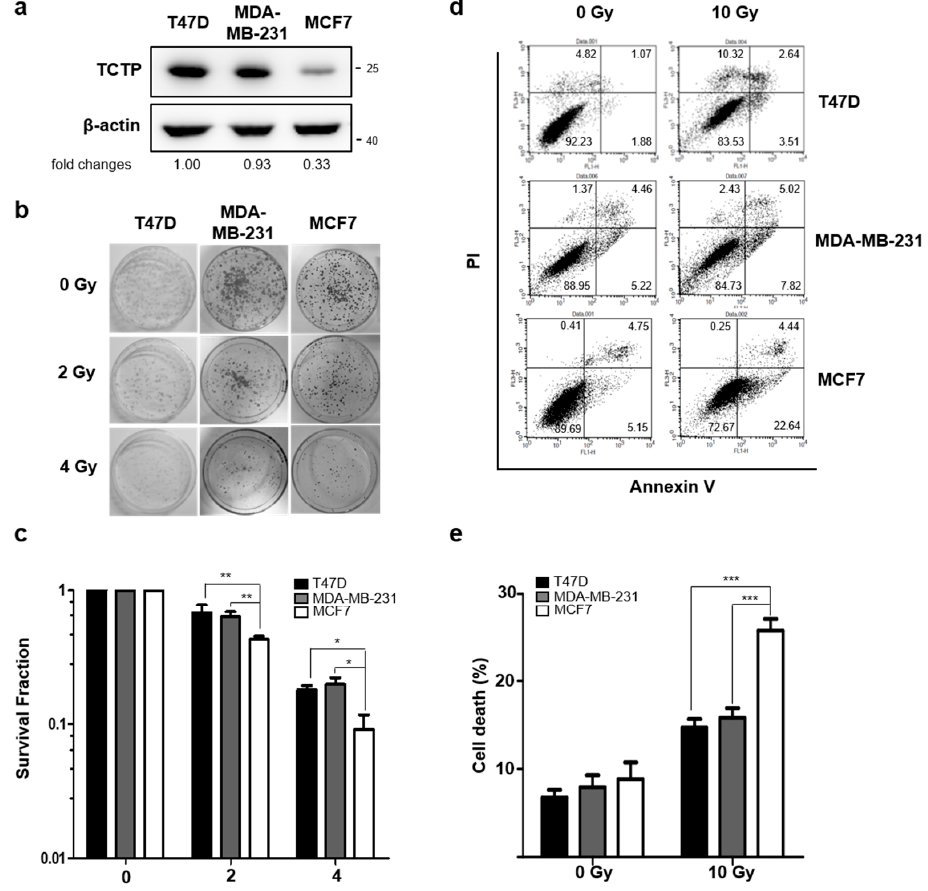
Figure 1. Translationally controlled tumor protein (TCTP) expression inversely correlates with sensitivity to γ -radiation in breast cancer cells. ( a ) TCTP expression of breast cancer cell lines were determined by Western blotting ( n = 4). The cropped blots are used in the figure and full-length blots are presented in Figure S5. The relative level of TCTP in comparison to β -actin is indicated below each immunoblot image. ( b , c ) The cells were treated with different doses of γ -radiation, and the survival fraction was determined by a clonogenic formation assay ( n = 3). ( b ) Representative image of clonogenic formation. ( c ) Survival fraction relative to each untreated group was calculated and shown in the graph. ( d , e ) Cells were treated with γ -radiation of 10 Gy and dead cell populations were determined by flow cytometry after staining with Annexin V and PI ( n = 4). ( d ) Representative image of PI-Annexin V double staining examined in breast cancer cells and ( e ) graph of dead cells is shown. Bars represent the means ± SEM. * p < 0.05, ** p < 0.01, *** p < 0.001 by two-way analysis of variance.